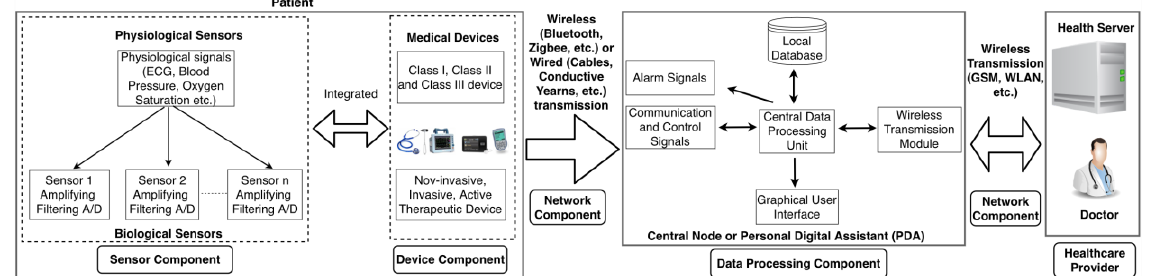
Figure 9. Overview of an example healthcare system [73]. Abbreviations used: ECG, Electrocardiogram; GSM, Global System for Mobile Communications; WLAN, Wireless Local Area Network; and A/D, Analog-to-Digital Converter. Reprinted with permission from ref. [73]. 2021 Association for Computing Machinery.